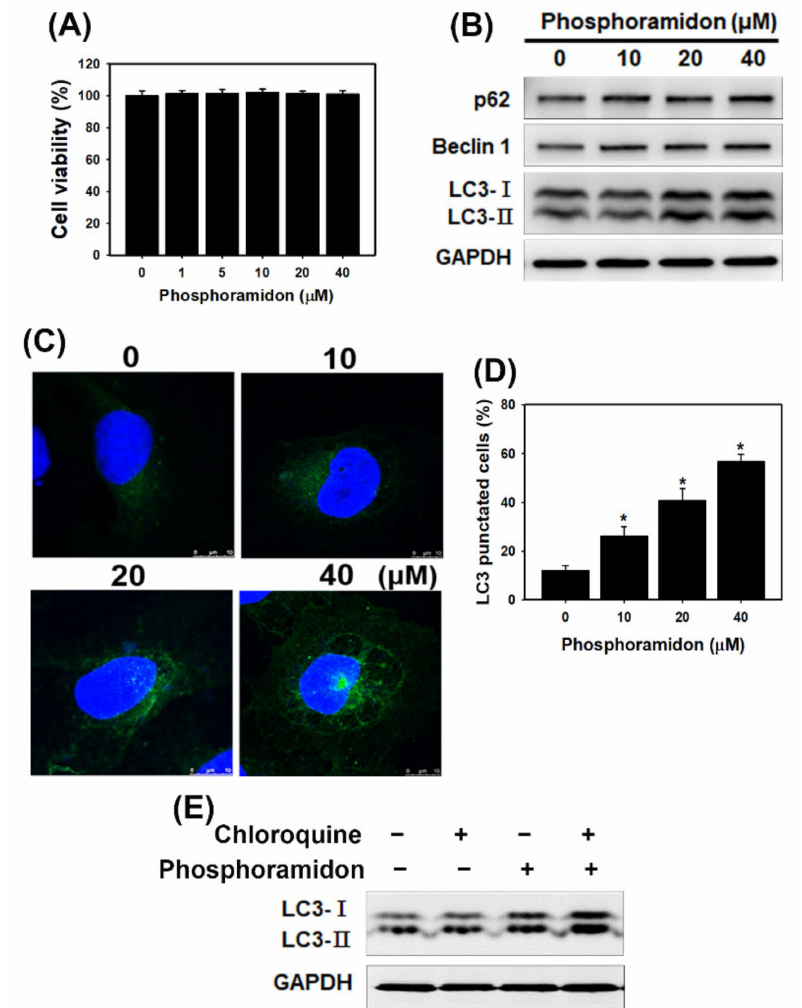
Figure 3. Phosphoramidon triggers autophagy in HK-2 cells. ( A ) Cell viability of phosphoramidon- treated cells. Cells were treated with several concentrations of phosphoramidon for 24 h. Data were presented as the means ± standard deviation of three independent experiments. ( B ) The protein levels of p62, beclin 1 and LC3 in HK-2 cells treated with phosphoramidon for 24 h. ( C ) Imaging of LC3 by confocal immunofluorescence microscopy following 24 h of treatment with phosphoramidon. Scale bar = 10 µ m. ( D ) Quantification of punctate LC3 staining. Cells were treated with various concentrations of phosphoramidon for 24 h. * p < 0.05 compared with the control. Data were presented as the means ± standard deviation of three independent experiments. ( E ) Western blotting of LC3-I and LC3-II expression in HK-2 cells. The cells were pretreated with chloroquine (5 µ M) for 1 h and then treated with phosphoramidon (20 µ M) for 24